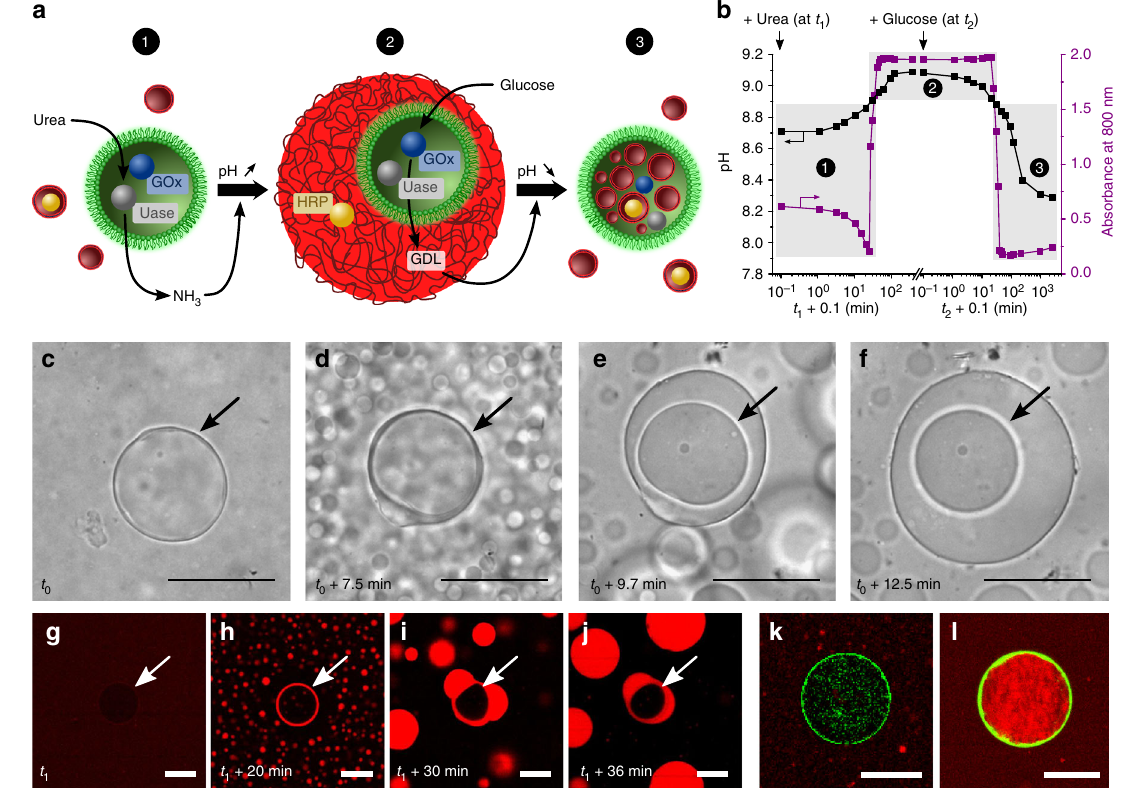
Fig. 5 Self-induced capture of proteinosomes by enzyme-mediated vesicle-to-coacervate transitions. a Graphic showing restructuration of a mixed population of proteinosomes (green) containing encapsulated GOx (blue circle) and urease (Uase, grey circle) in the presence of non-encapsulated fatty acid vesicles (red) containing HRP (yellow circle) (state 1) into a nested proteinosome-in-coacervate micro-architecture (state 2) after addition of urea, followed by transformation into a vesicle-in-proteinosome structure (state 3) after addition of glucose. b Time-dependent plot showing sequential increase in pH after addition of 20 mM urea (at t 1 = 0, black squares) to a mixed population of fatty acid vesicles and urease/GOx-containing proteinosomes, and associated rapid increase in absorbance (purple circles) due to the transformation of vesicles into micelle coacervate micro-droplets above pH 8.9. Subsequent addition of 10 mM glucose (at t 2 = 0) produces a decrease in pH, and an associated rapid decrease in absorbance due to disassembly of the micelle coacervate droplets into vesicles below pH 8.9. The conversion from state 1 to 3 as labelled in a is highlighted. c – f Time series of optical microscopy images showing self-induced capture of a urease/GOx-containing proteinosome (arrow) via urease-mediated transformation of fatty acid vesicles into micelle coacervate droplets in the presence of urea (20 mM; time t 0 ) (see Supplementary Movie 4). Scale bars, 50 μ m. g – j As for c – f , but imaged by confocal fl uorescence microscopy showing single proteinosome (white arrow) and vesicles ( g ) followed by formation of fatty acid coacervate droplets and initial stages of wetting of the urease/GOx-containing proteinosome 20 min after addition of urea ( h ). Capture of the proteinosome occurs via the interfacial coalescence of several coacervate droplets ( i , j ); scale bars, 50 μ m. k , l Confocal fl uorescence microscopy images of a single urease/GOx- containing FITC-labelled proteinosome (green fl uorescence) in the presence of RITC-HRP-loaded fatty acid vesicles before ( k ) and after ( l ) sequential addition of urea (20 mM, 180 min) and glucose (10 mM, 240 min). Initially, vesicles containing RITC-HRP (red fl uorescence) are excluded from the proteinosome lumen (ratio of red fl uorescence inside vs. outside the proteinosomes, I IN / I OUT = 0.5 ± 0.1), whilst after enzyme-mediated pH-induced host – guest protocell assembly and recon fi guration, many of the vesicles are located along with their payload in the proteinosome interior ( I IN / I OUT = 2.1 ± 0.1); scale bars, 50 μ together, these results demonstrate that proteinosome-mediated disassembly of host micelle coacervate droplets into fatty acid vesicles is a mechanism to selectively transfer and accumulate payloads into membrane-bound nested hybrid protocells com- prising multiple vesicle sub-compartments housed within single enzymatically active proteinosomes.